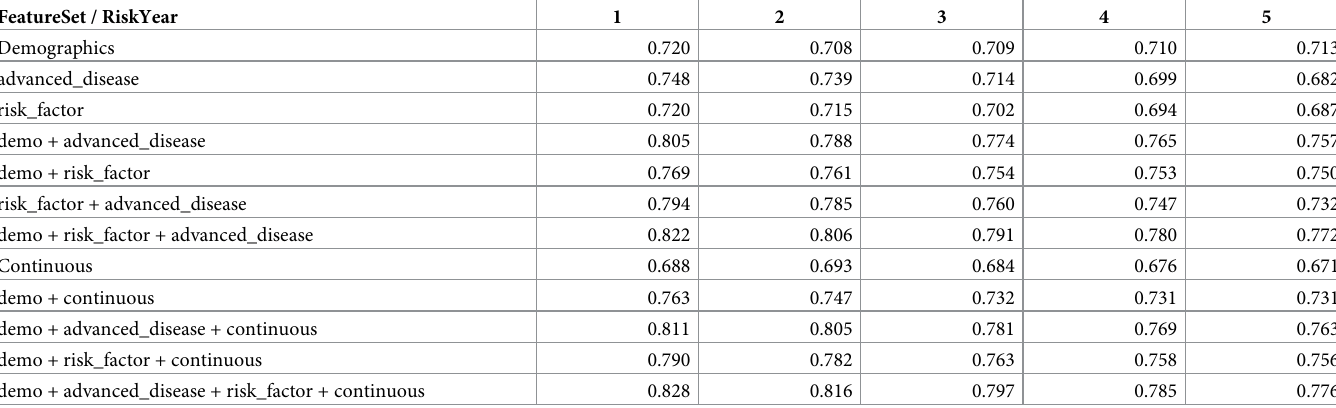
Table 3. Max Model with C-Index Results. Feature Sets versus Risk